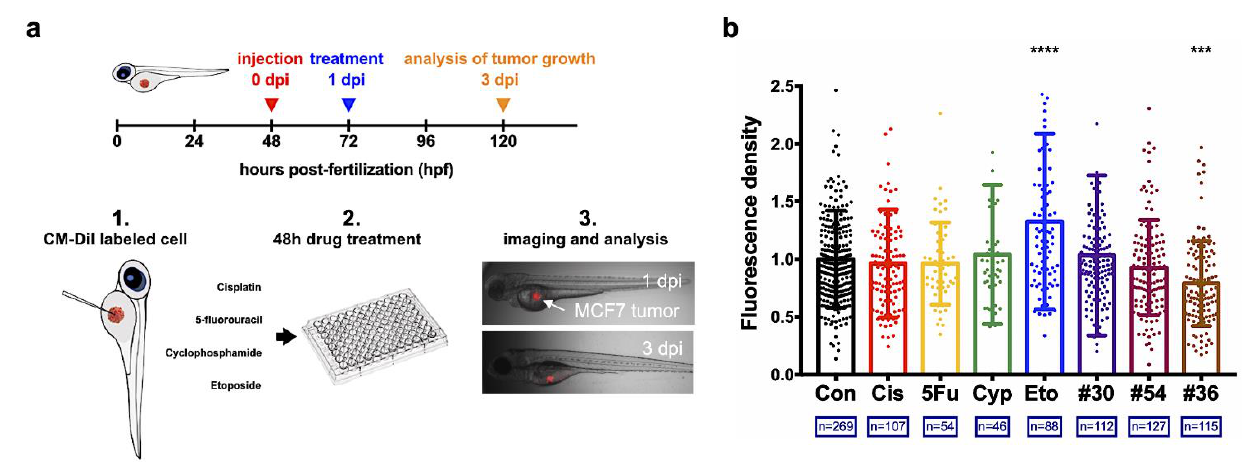
Figure 5. Verification of the drug combination efficacy via the in vivo zebrafish tumor xenograft models: ( a ) Procedure of the zebrafish xenograft assay; MCF-7 cells were used for this model. ( b ) In vivo tumor inhibiting rates of the evaluated drug combinations from the µ CA chip and the corresponding single drugs used. The concentrations of cisplatin (Cis), 5-fluorouracil (5Fu), cyclophosphamide (Cyp), and etoposide (Eto) were 15 µ g/mL (49.8 µ M), 3000 µ g/mL (23,280 µ M), 400 (1532 µ M) µ g/mL, and 10 µ g/mL (17 µ M), respectively. Groups #30, #36 and #54 are given in Figures S2 and S3. “n” indicates the total number of zebrafishes used for each assay. Each datum was normal- ized by the average fluorescence density (intensity/pixel2) of control group (Con). *** p < 0.001 and **** p < 0.0001. Table 1. Characteristics of the µCA chip, 96-well plate, and zebrafish model.